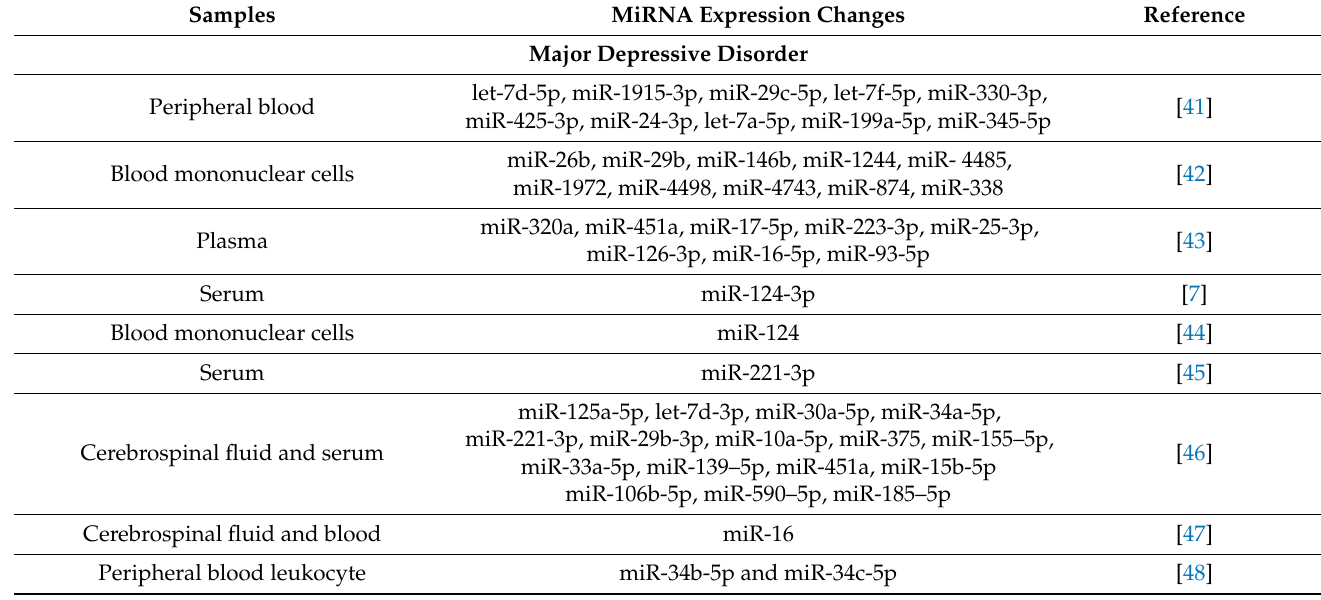
Table 1. miRNA expression changes in major depressive disorder, bipolar disorder, and suicidal